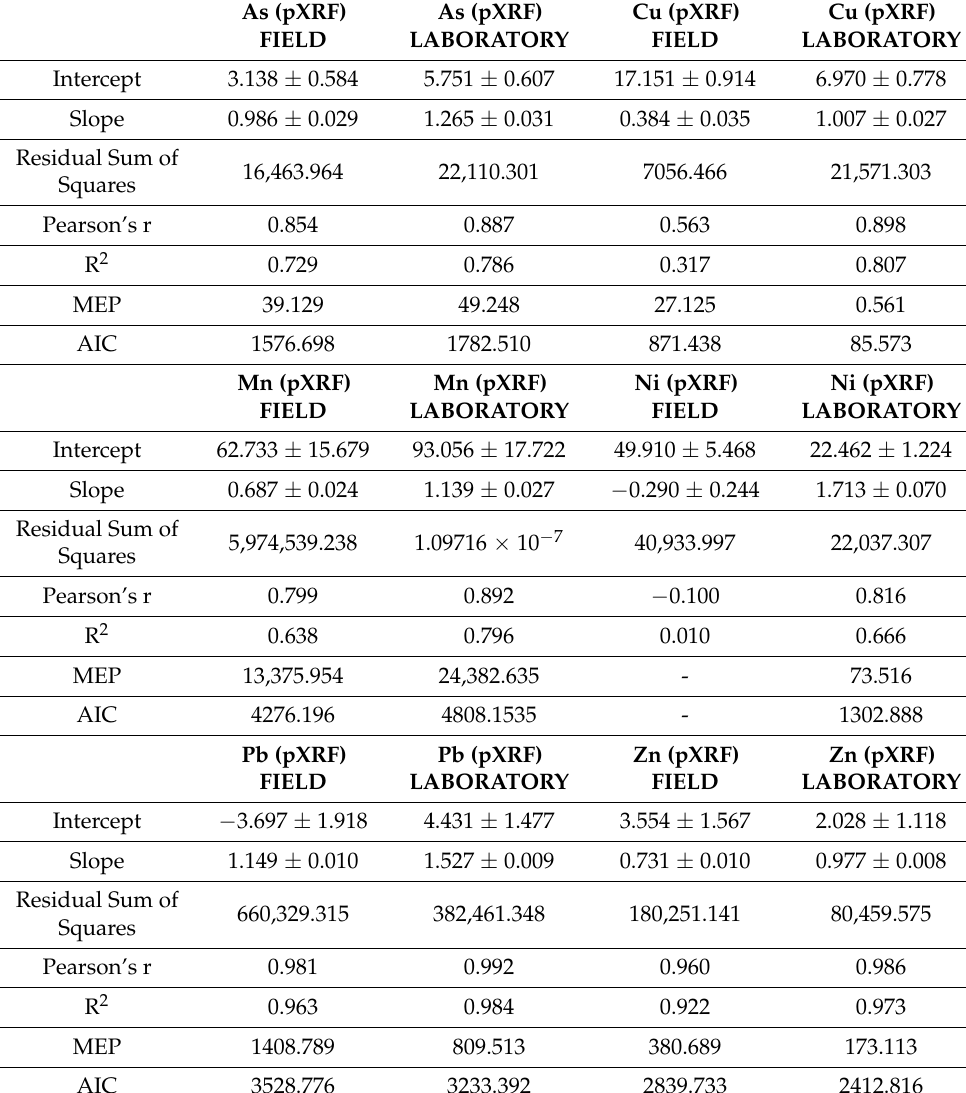
Table 1. Model characteristics of the pXRF–FIELD and pXRF–LABORATORY comparison for As, Cu, Mn, Ni, Pb and